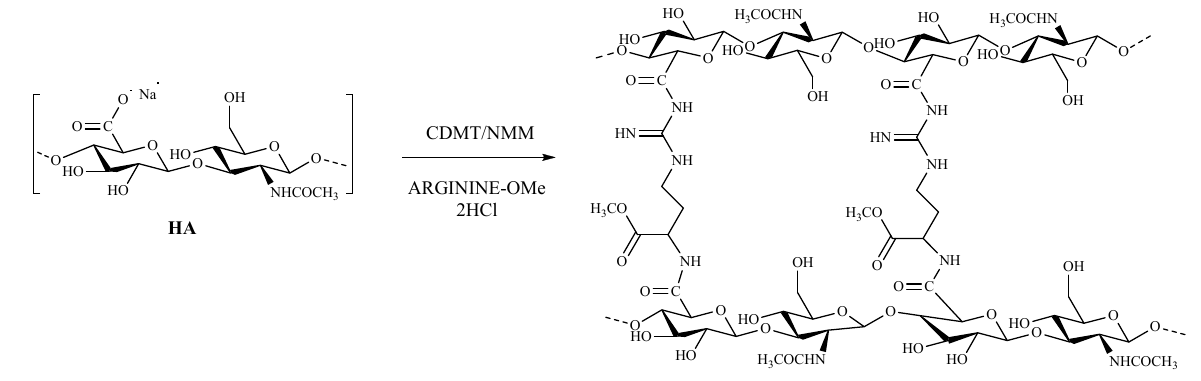
Figure 1. Schematic synthesis of the cross-linked HA-Arg.